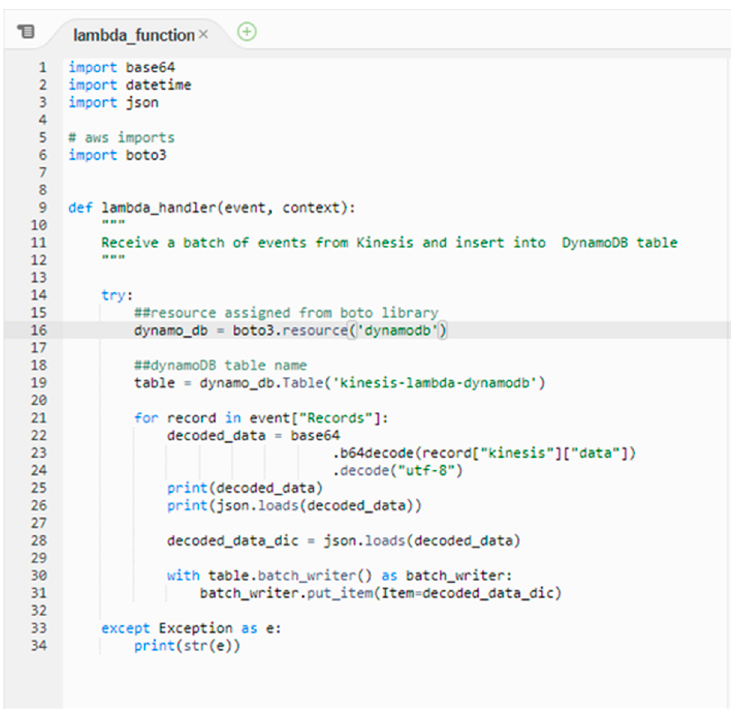
Figure A1. Lambda Function. Lines 1–6: Importing required packages. Line 9: function definition responsible for AWS Lambda invocations. Line 16: Accessing DynamoDB resources using AWS Boto Client. Line 19: Accessing DynamoDB table. Lines 21–31: Loop to iterate through all records in the function payload and push the decoded data to the DynamoDB